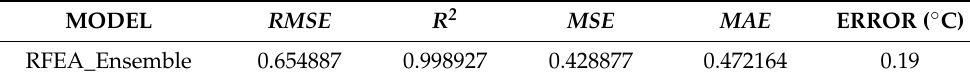
Figure 15. Testing the machine learning using data generated using finite element analysis. Actual stress vs. predicted stress. Table 5. RFEA Validation Results.